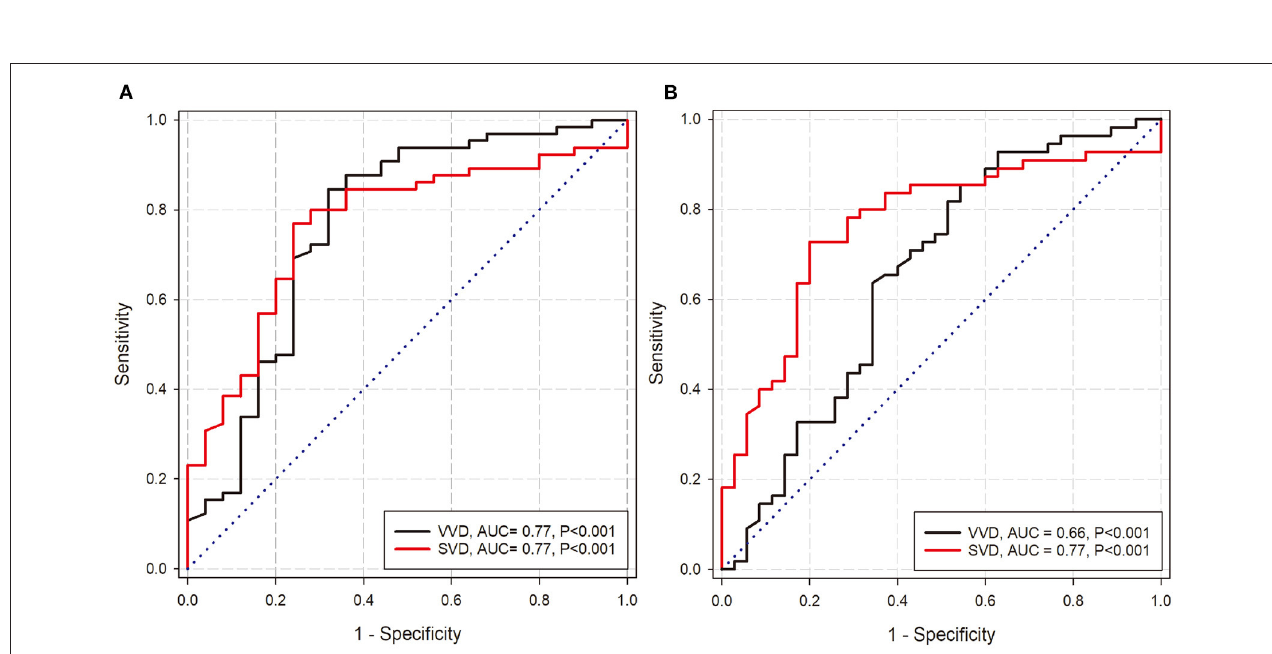
FIGURE 3 | Prediction of DR and PDR by vitreous and serum 25 (OH) D. (A) The ROC-curve of the serum 25 (OH) D and vitreous 25 (OH) D for predicting DR. (B) The ROC-curve of the serum 25 (OH) D and vitreous 25 (OH) D for predicting PDR. [SVD: serum 25 (OH) D; VVD: vitreous 25 (OH)